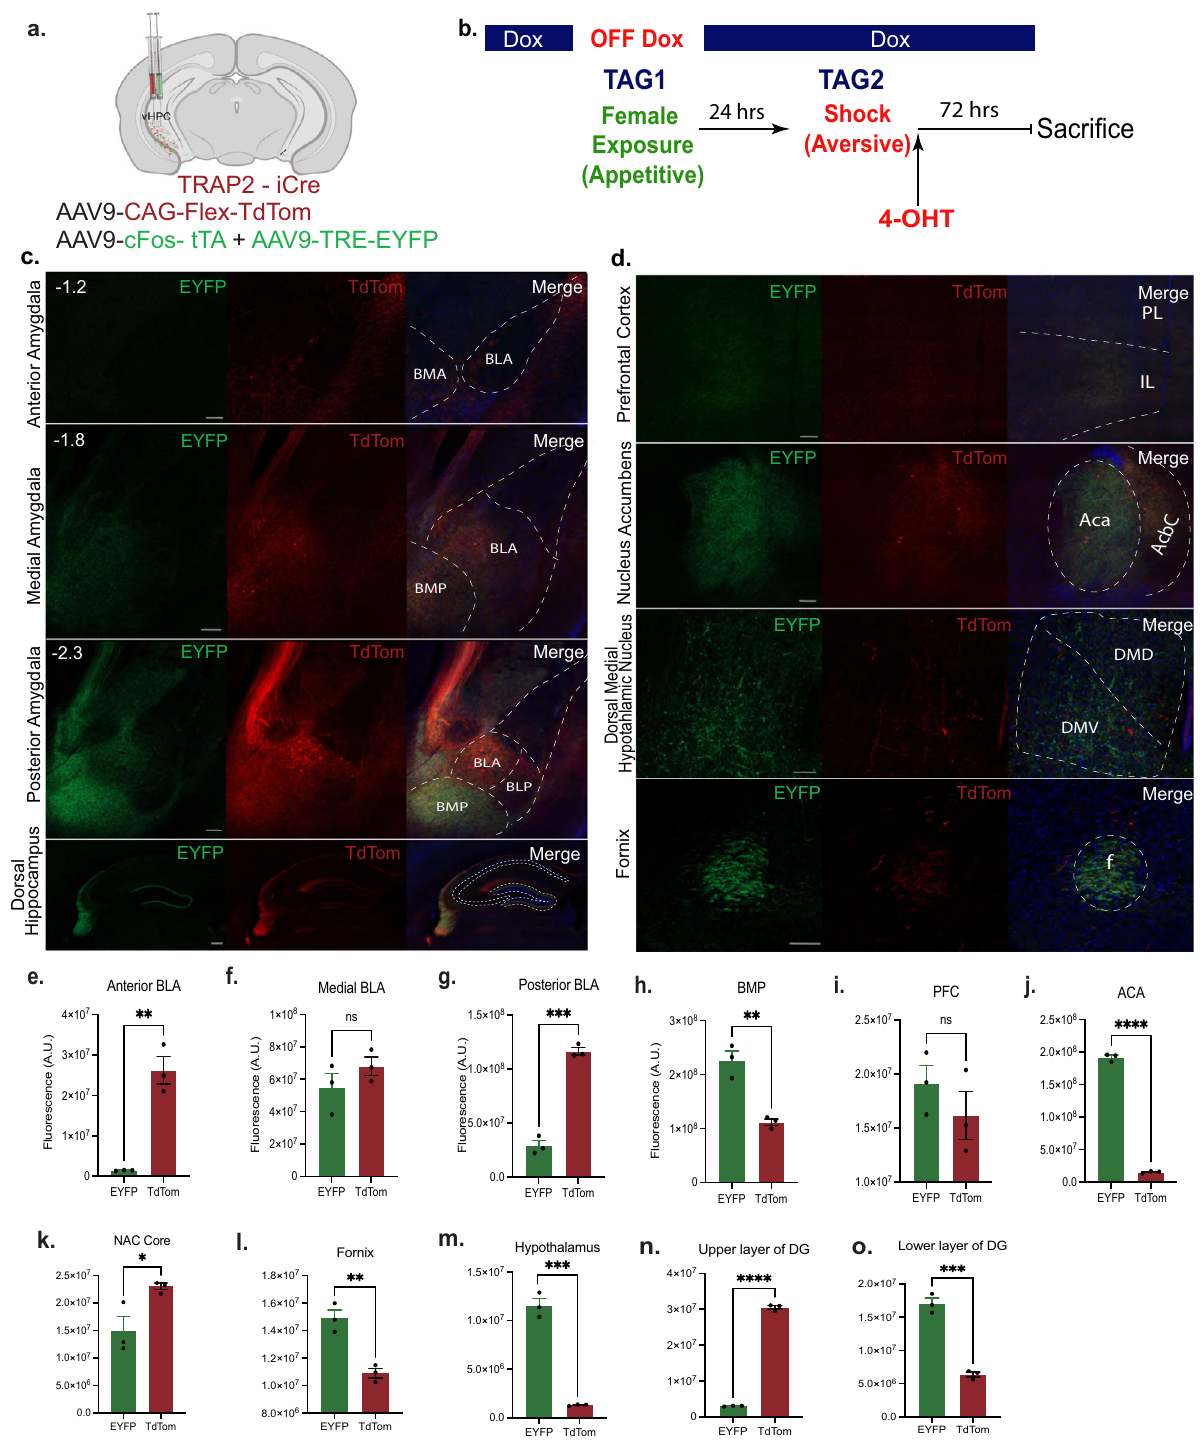
Fig. 2 Ventral hippocampal neurons encoding appetitive or aversive valences have discrete projection patterns. a Fos-CreERT2 mice were injected with a viral cocktail of 1:1 ratio of AAV9-c-Fos-tTA and AAV9-TRE-EYFP mixed in with AAV-Flex-DIO-TdTomato into the vHPC for dual memory tagging. b Experimental timeline for tagging; EYFP represents aversive and TdTomato represents appetitive. c , d Representative images of terminal projections; anterior, medial, and posterior BLA, dorsal hippocampus, prefrontal cortex, nucleus accumbens, dorsal medial hypothalamic nucleus, and the fornix. Arbitrary units for EYFP (appetitive) and TdTom (aversive) ( N = 3) for the e , anterior BLA (unpaired student ’ s t-test t = 7.279, df = 4, p = 0.00019), f medial BLA (t = 1.271, df = 4; p = 0.2725), g , posterior BLA (t = 14.95, df = 4; p = 0.0001), h , BMP (t = 6.168, df = 4; p = 0.0035), i , PFC (includes IL and PL) (t = 1.078, df = 4; p = 0.3419), j , ACA (t = 50.68, df = 4; P < 0.0001), k , NAc Core ( t = 3.018, df = 4; p = 0.0392), l , fornix (t = 5.718, df = 4; p = 0.0046), m , hypothalamus t = 13.96, df = 4; p = 0.0002, n , upper layer of DG(t = 54.94, df = 4; p < 0.0001) , o , lower layer of DG (t = 11.73, df = 4; p = 0.0003). ns = p > 0.05. Error bars represent mean ± SEM. Scale bars are all 100 μ